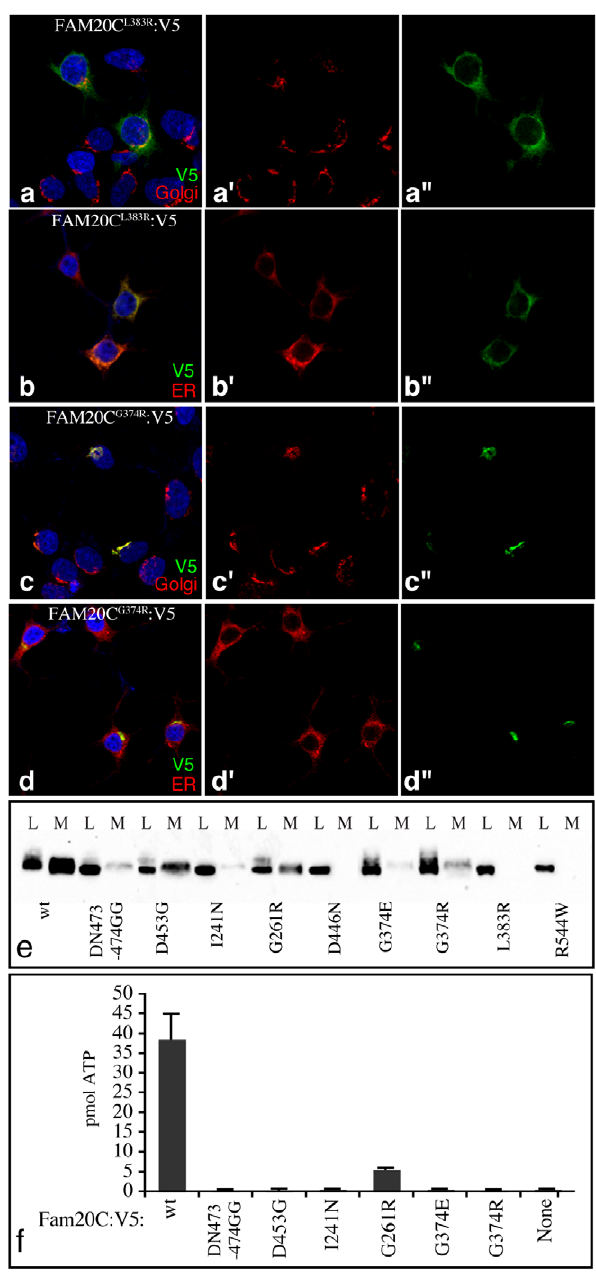
Figure 4. Localization and activity of FAM20C mutant isoforms. A–d Examples of localization of the indicated V5-tagged FAM20C mutant proteins (green) transfected into 293 cells, as compared to a Golgi markers (Giantin, a,c, red) or an ER marker (anti-KDEL, b,d red). Nuceli are labeled by DAPI (blue). Panels marked by prime symbols show single channels of the merged image to the left. e) Western blot showing localization of FAM20C mutant proteins in the lysate (L) and/or medium (M) of 293 cells. f) Results of kinase assays using the indicated FAM20C mutant proteins and the OPN-ASARM peptide as a substrate. doi:10.1371/journal.pone.0042988.g004 DMP1:FLAG, DSPP:FLAG and MEPE:FLAG were detected by Western blotting. Phosphatase treatments to reverse mobility shifts were performed using Antarctic phosphatase (New England Biolabs).